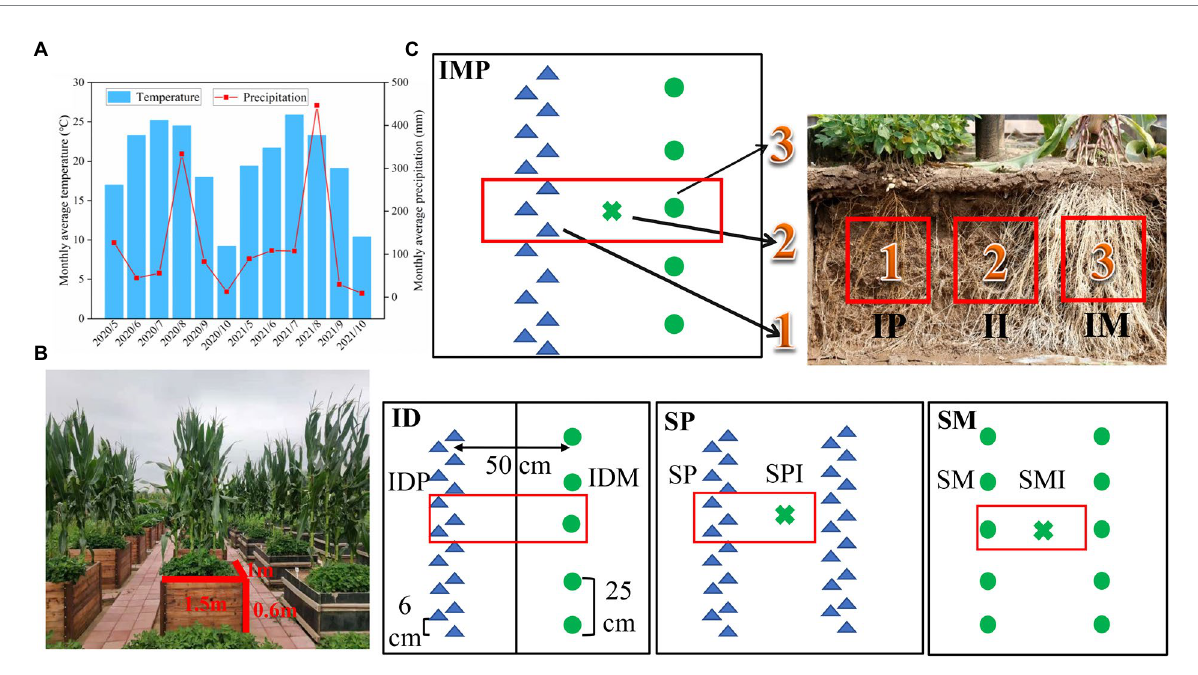
FIGURE 1 Overview of the root box simulation experiment. (A) The average monthly temperature and precipitation in the 2020 and 2021 growing seasons. (B) The distribution of root box simulation experiment. (C) Diagram of plant and soil samples in different root interaction patterns. ● : maize plants, ▲ : peanut plants, □ : plant and rhizosphere soil sample area, ×: the shared soil sample. IP: intercropped peanut, II: the shared soil of intercropped maize and peanut, IM: intercropped maize, IDP: intercropped peanut with board separation, IDM: intercropped maize with board separation, SP: sole peanut, SPI: the shared soil of sole peanut, SM: sole maize, SMI: the shared soil of sole